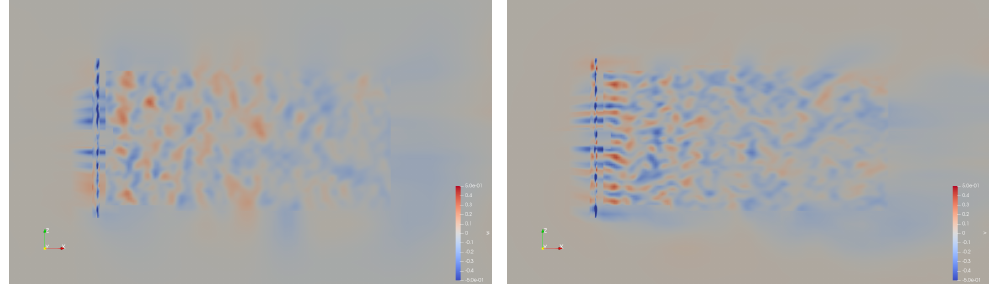
Figure 8. Flow velocity components u 2 ( left ) and u 3 ( right ) at representative time step t 1 > T conv .